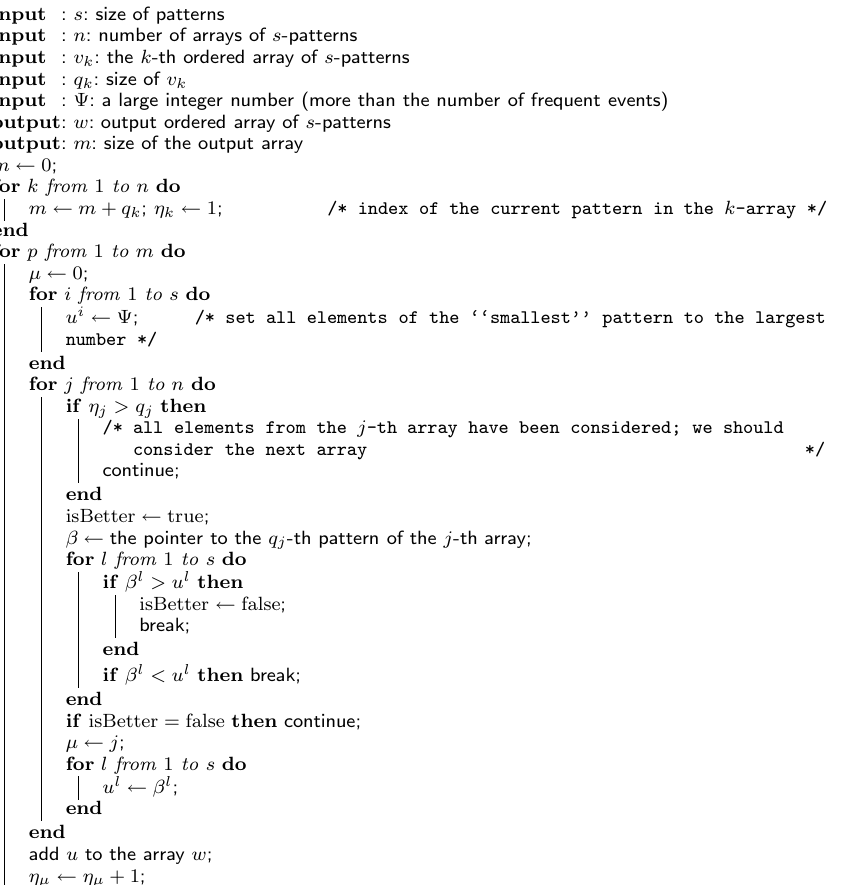
Algorithm 3: Merging n ordered lists of s -patterns without common s